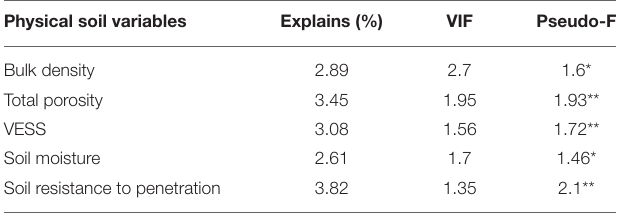
TABLE 6 | Canonical correspondence analysis (CCA) permutation test results examining the association between termite species composition with physical soil